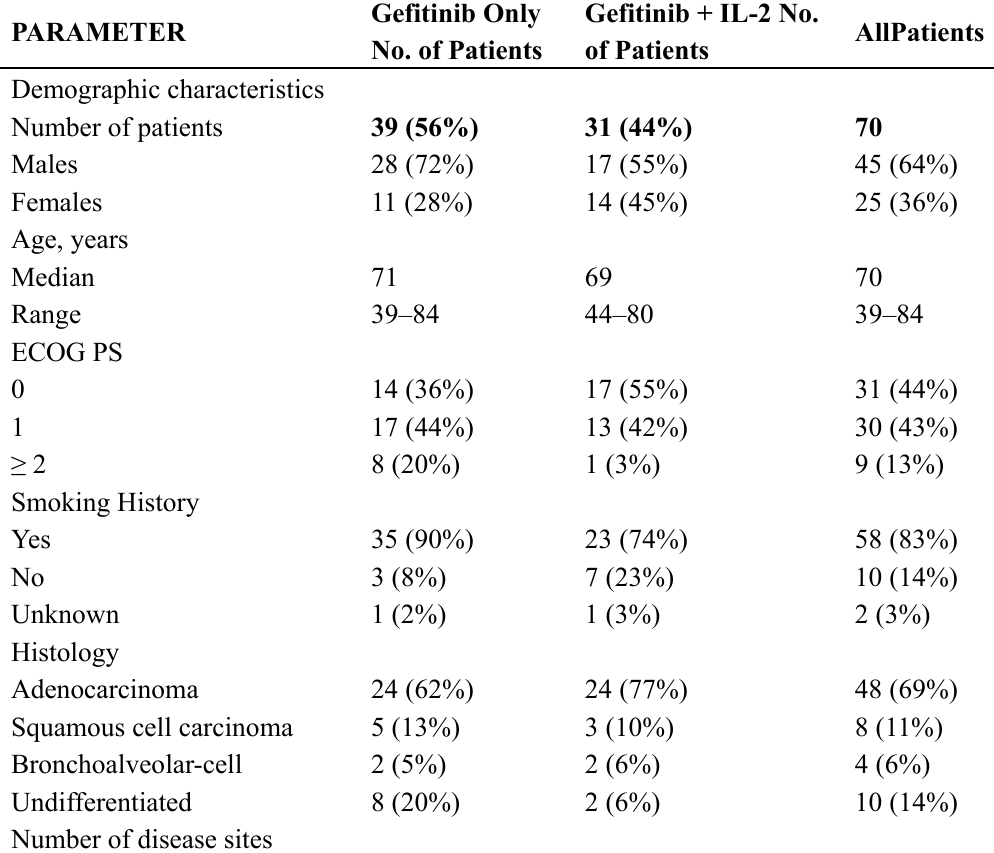
Table 2. Patients’ demographics and disease